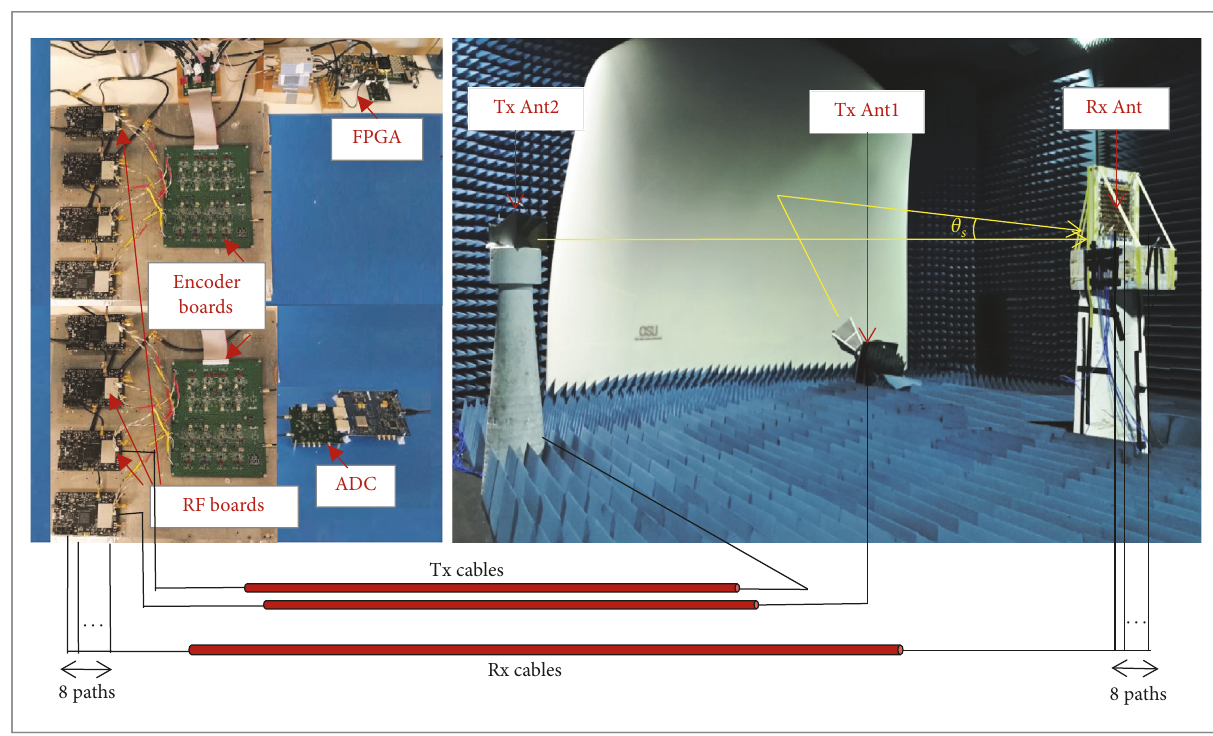
Figure 7: Eight-channel OSCR on the workstation outside the chamber. Also shown is the setup inside the anechoic chamber with two transmitting horn antennas at different locations and 64-element receiver array mounted on a rotating foam column.